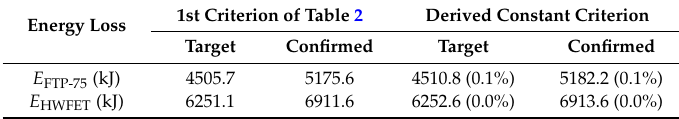
Table 4. Energy loss comparison for the derived